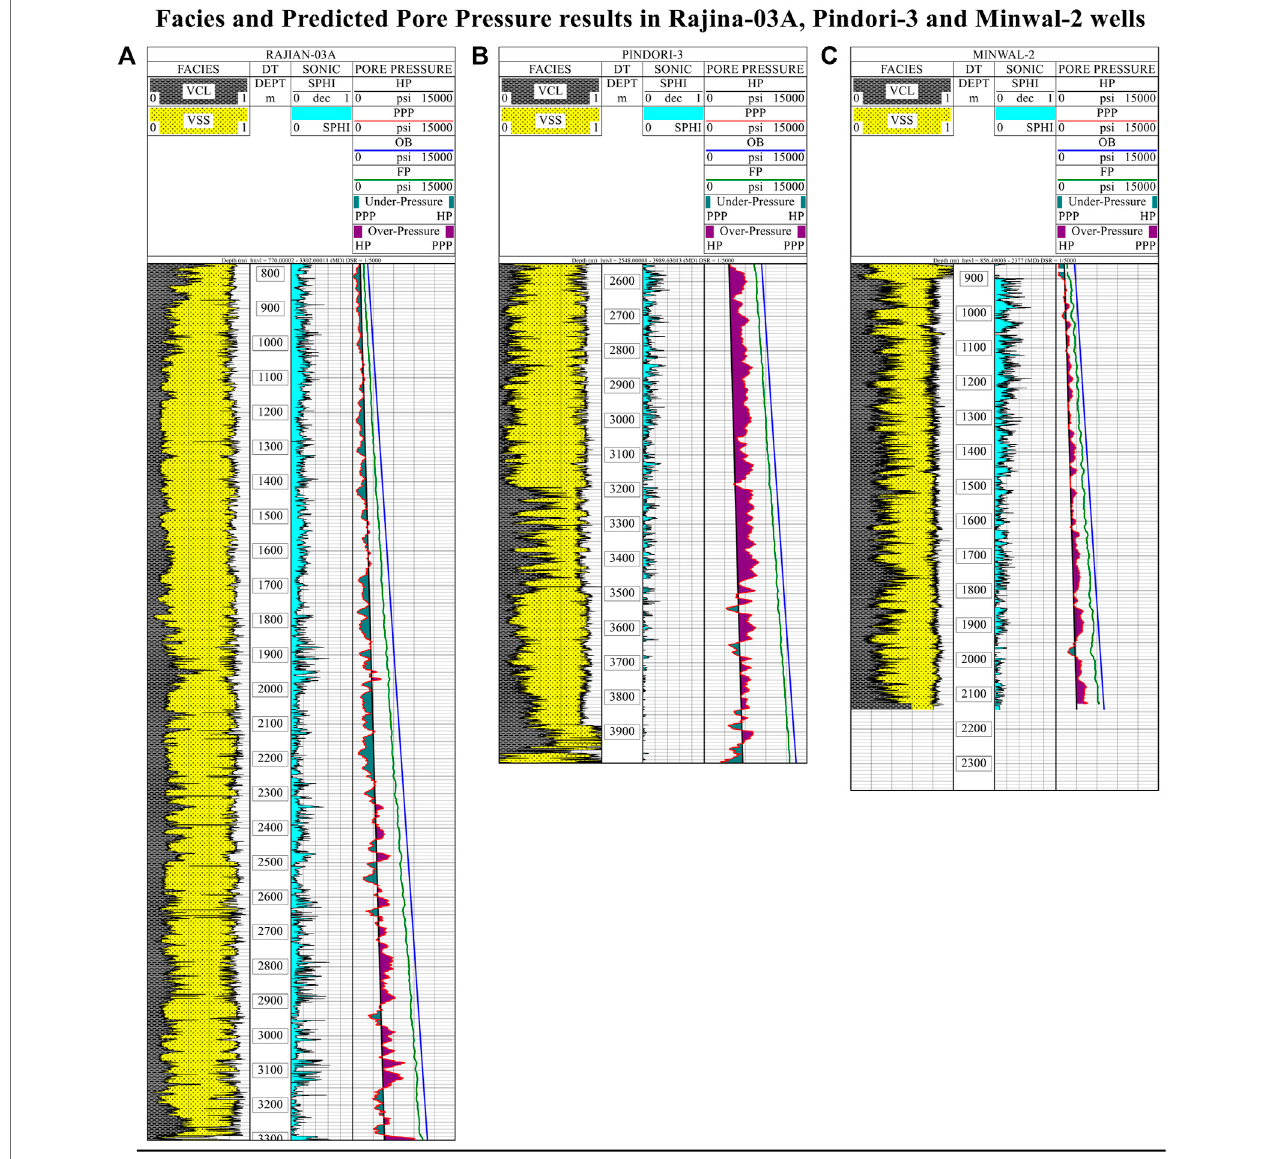
FIGURE 14 | Facies, porosity, and predicted pore pressure results in Rajian-03A, Pindori-3, and Minwal-2 wells. Plotted data include, predicted facies in facies track; porosity curve is plotted in sonic track; HP, OB, PPP, and FP plotted in the pore pressure track. In Rajian-03A well (A) , Murree Formation is having normal and underpressure condition withinmost of the formation except for twozones (at around 2800 m and 3000 m) inthe lower part where pressure isincreased. Pindori-3 well (B) mostlyrepresentsoverpressuredconditionsintheupperpartandconvertsintonormalpressuresinlowerpart.InMinwal-2well (C) ,mostoftheintervaldepicts near to hydrostatic pressures with few exceptions in the lower